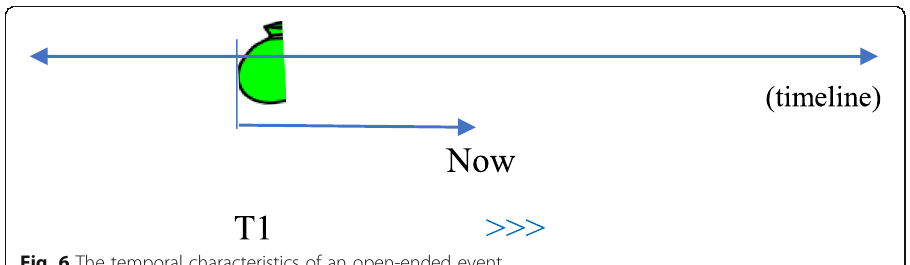
Fig. 6 The temporal characteristics of an open-ended